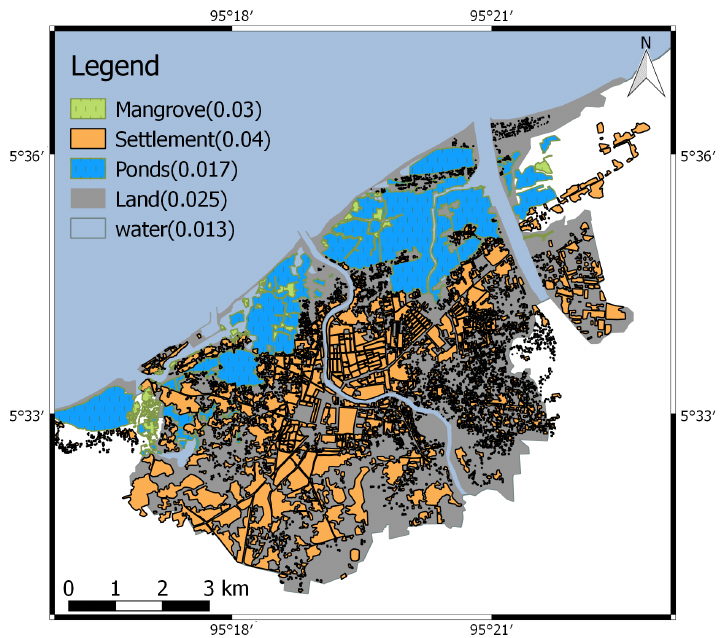
Figure 4. Distribution of Manning Coefficients in COMCOT-SED